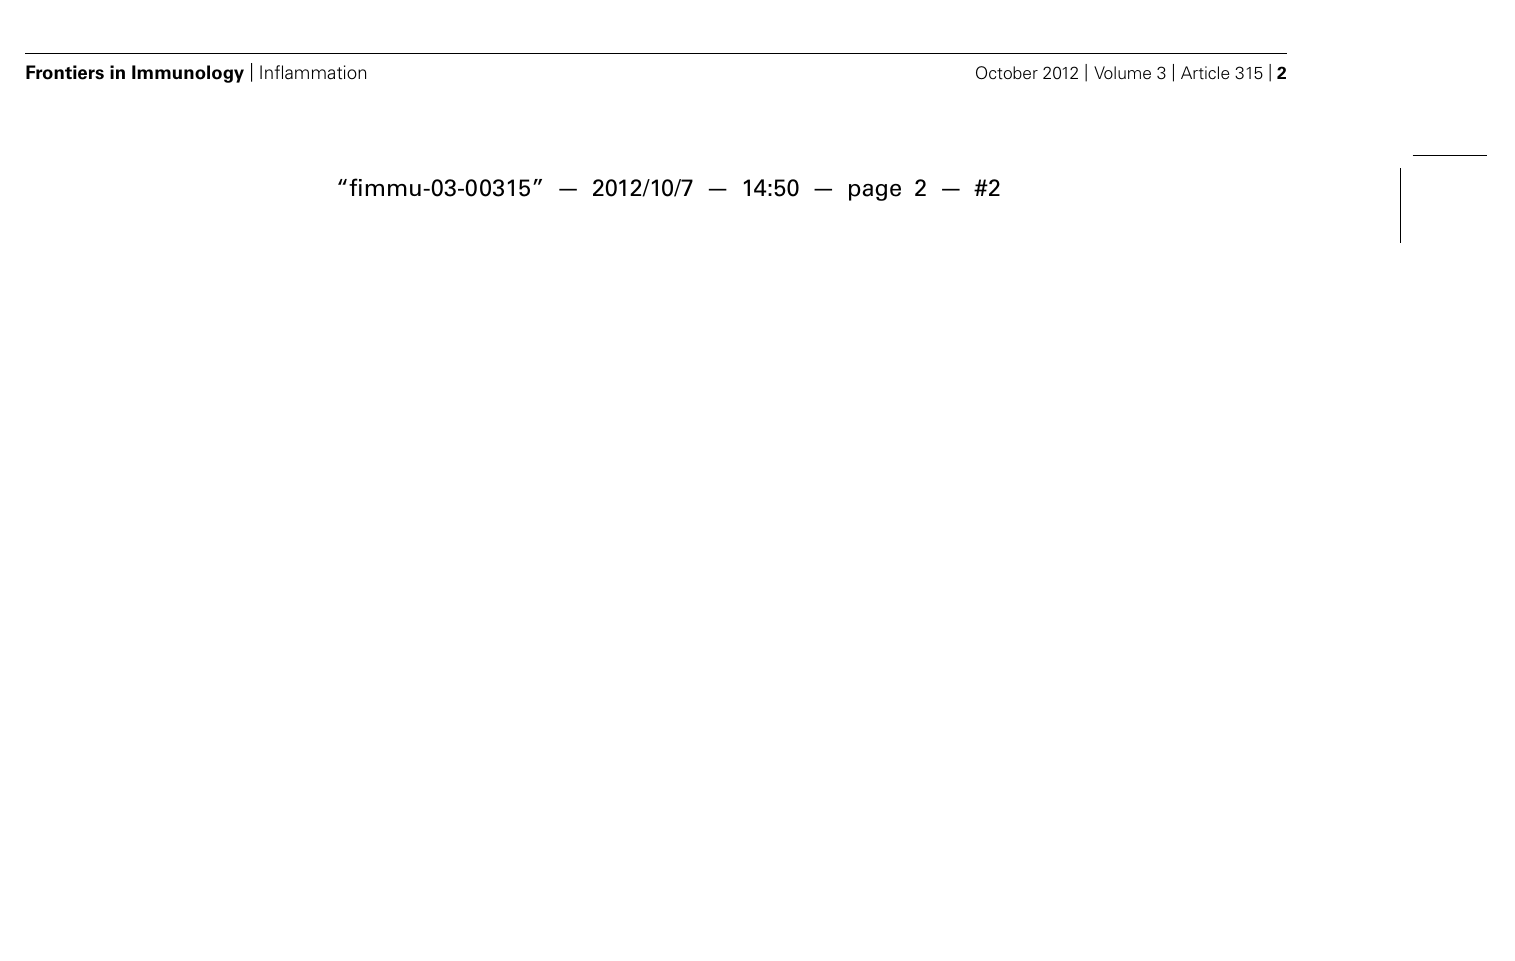
Frontiers in Immunology |